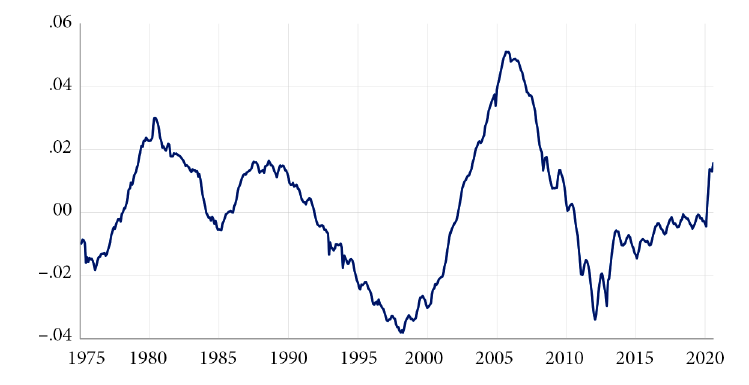
Figure 2. Deviations between the home price and its fundamental